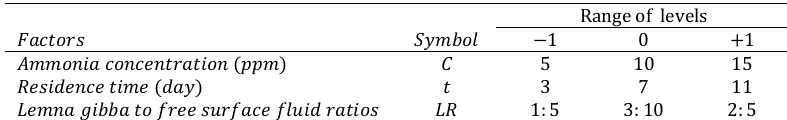
Table 3: The range of levels in variables